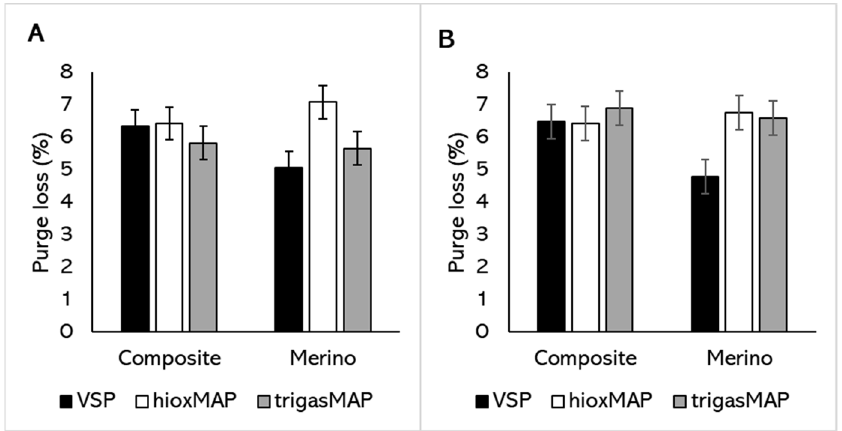
Figure 3. Purge loss of ( A ) Semimembranosus and ( B ) Vastus lateralis from two sheep breeds (Composite or Merino) in three retail packaging methods (VSP = vacuum skin packaging; HioxMAP = high-oxygen modified atmosphere packaging with 80% O 2 and 20% CO 2 ; or TrigasMAP = trigas modified atmosphere packaging with 50% O 2 , 30% N 2 and 20% CO 2 ). Values are predicted means ± standard error of differences (SED). p (breed × packaging method) values are 0.014 for Semimembranosus ( A ) and 0.015 for Vastus lateralis ( B ).